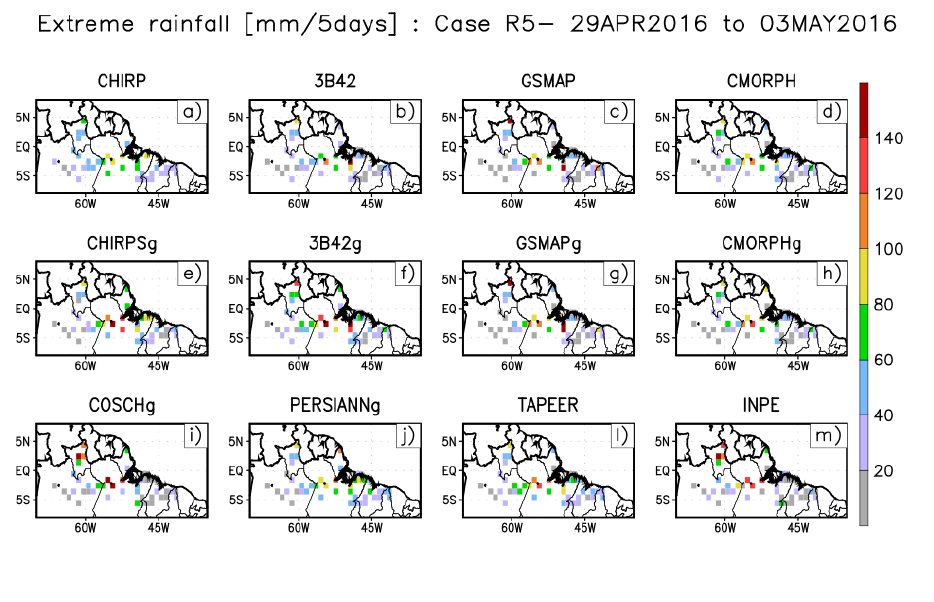
Figure 21. Case of extreme precipitation occurred over north Brazil (R5) from 29 April 2016 to 3 May 2016 estimated by different products ( a – m